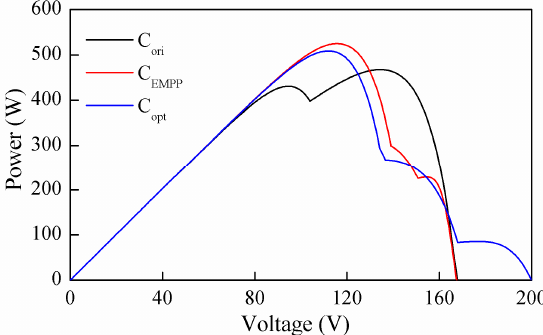
Figure 18. P-V curve of a PV array before and after reconfiguration.